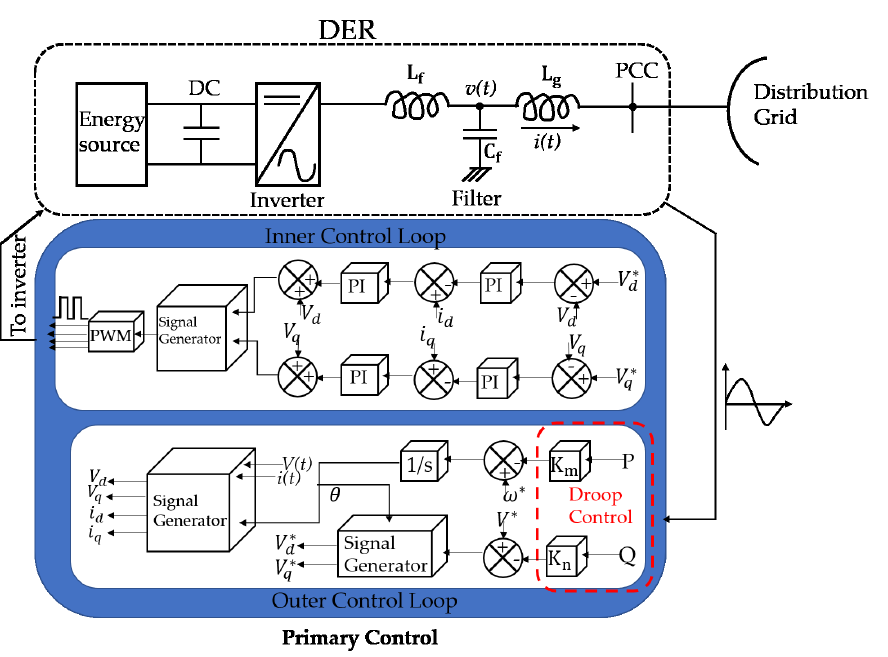
Figure 1. Schematic of an example of local control of a